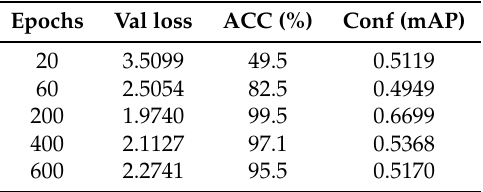
Table 2. Results of proposed hub object detection based on SSD7. Input image: [ ( h , w ) = ( 300,480 )